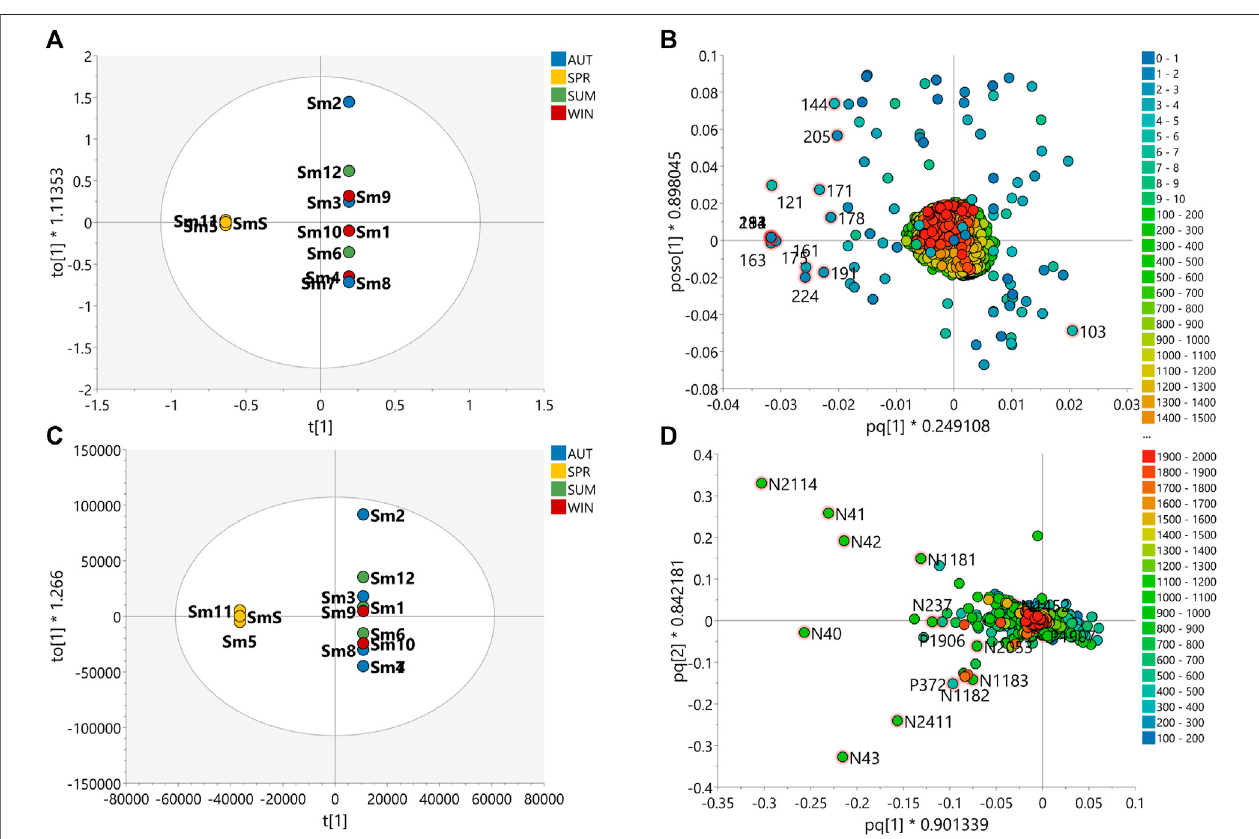
FIGURE 6 | Multivariate analyses of the data of S. marginata species for prediction of the seasonally discriminating metabolites. Orthogonal Partial Least Square- DiscriminantAnalysis(OPLS-DA)scorescatterplotof (A) MS-NMRfuseddataand (C) HRMSdatawithsamplescategorizedaccordingtotheharvestseason.OPLS-DA loadings plots with highlighted features of the 15 VIP metabolites of (B) MS-NMR fused data and (D) HRMS data. More scattered samples: Spring (Sm5, Sm11 and SmS); Less scattered samples: Summer (Sm1, Sm6 and Sm12); Autumn (Sm2, Sm3, Sm7 and Sm8); Winter (Sm4, Sm9 and Sm10) and Spring (Sm5, Sm11 and